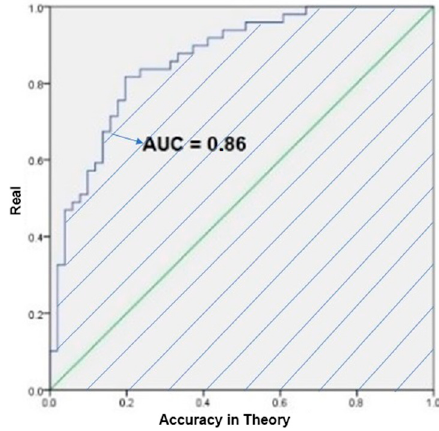
Figure 6. Receiver operating characteristic (ROC) curve constructed from the historical flash flood screening system compared with the Thuan Chau flood risk map. AUC: area under curve.